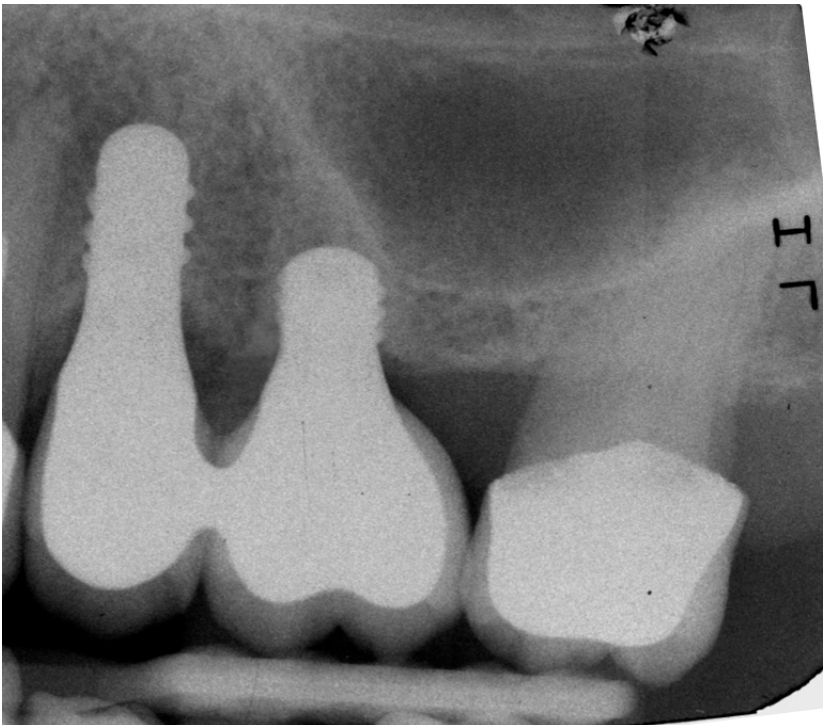
Figure 5. Radiograph of extra short and long implants at 24-month follow-up.